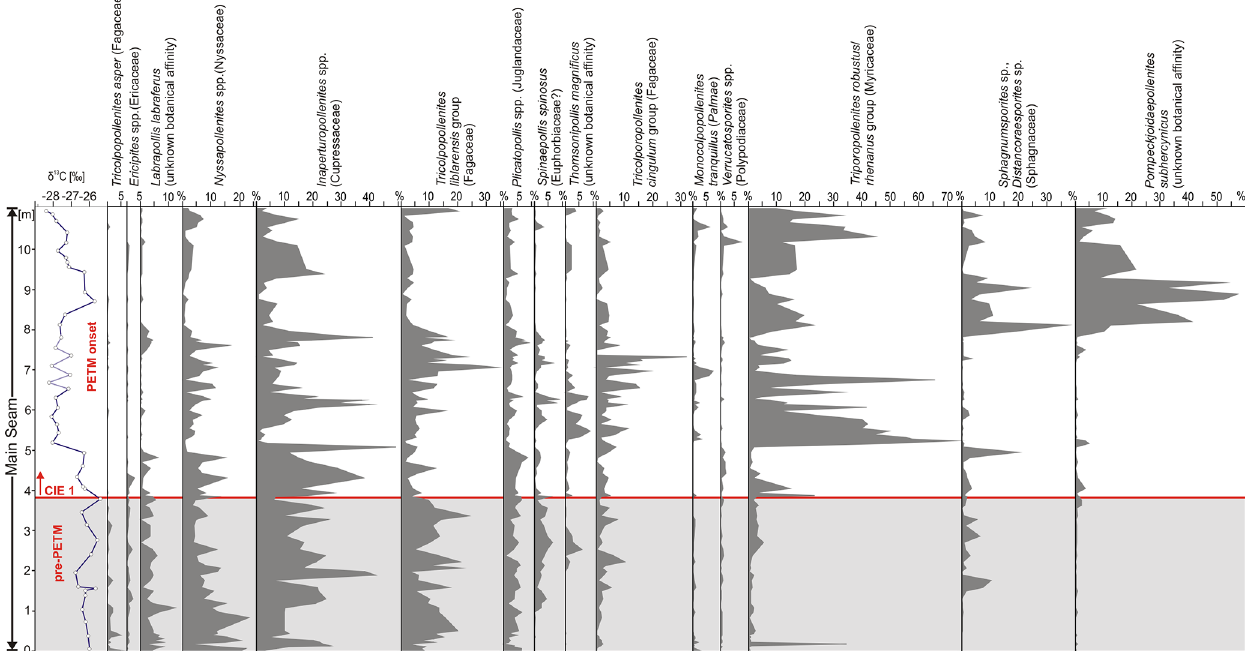
Figure 8. Simplified pollen diagram of the Main Seam, showing frequency and palynological abundance changes between the pre-PETM and peak-PETM intervals. The δ 13 C values of bulk organic matter (see Fig. 4 for the complete dataset) are shown for comparison. Due to the different thicknesses of the studied sections for isotopes and palynology, the isotope curve for the Main Seam has been tied to the top and base of the seam. The red line indicates the beginning of the PETM-related